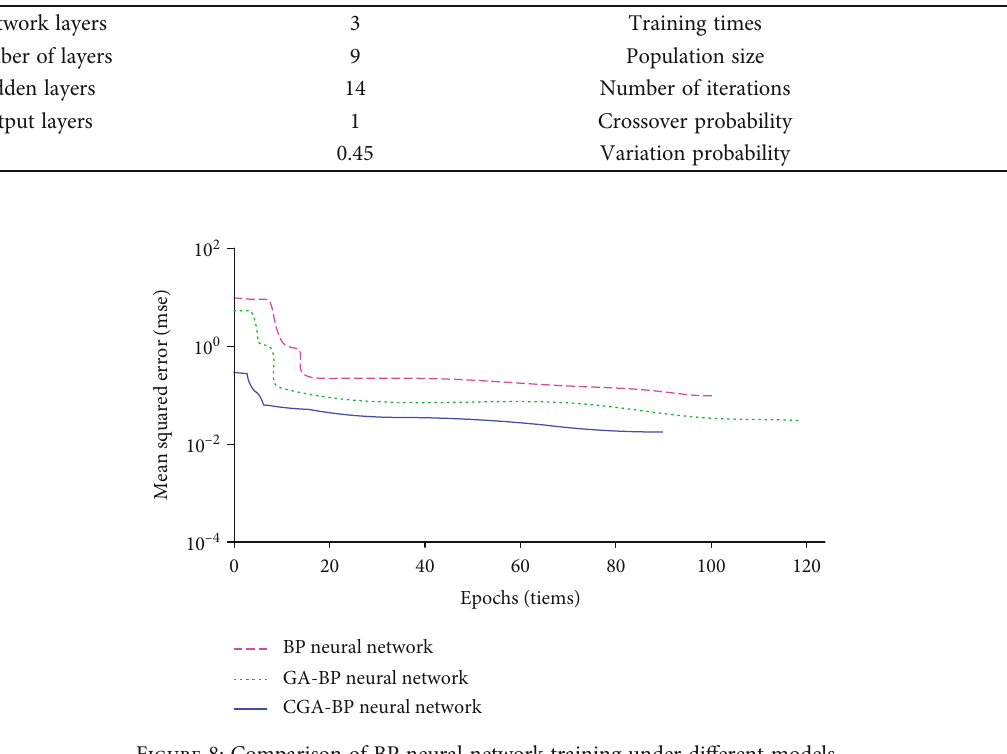
Figure 8: Comparison of BP neural network training under di ff erent models.